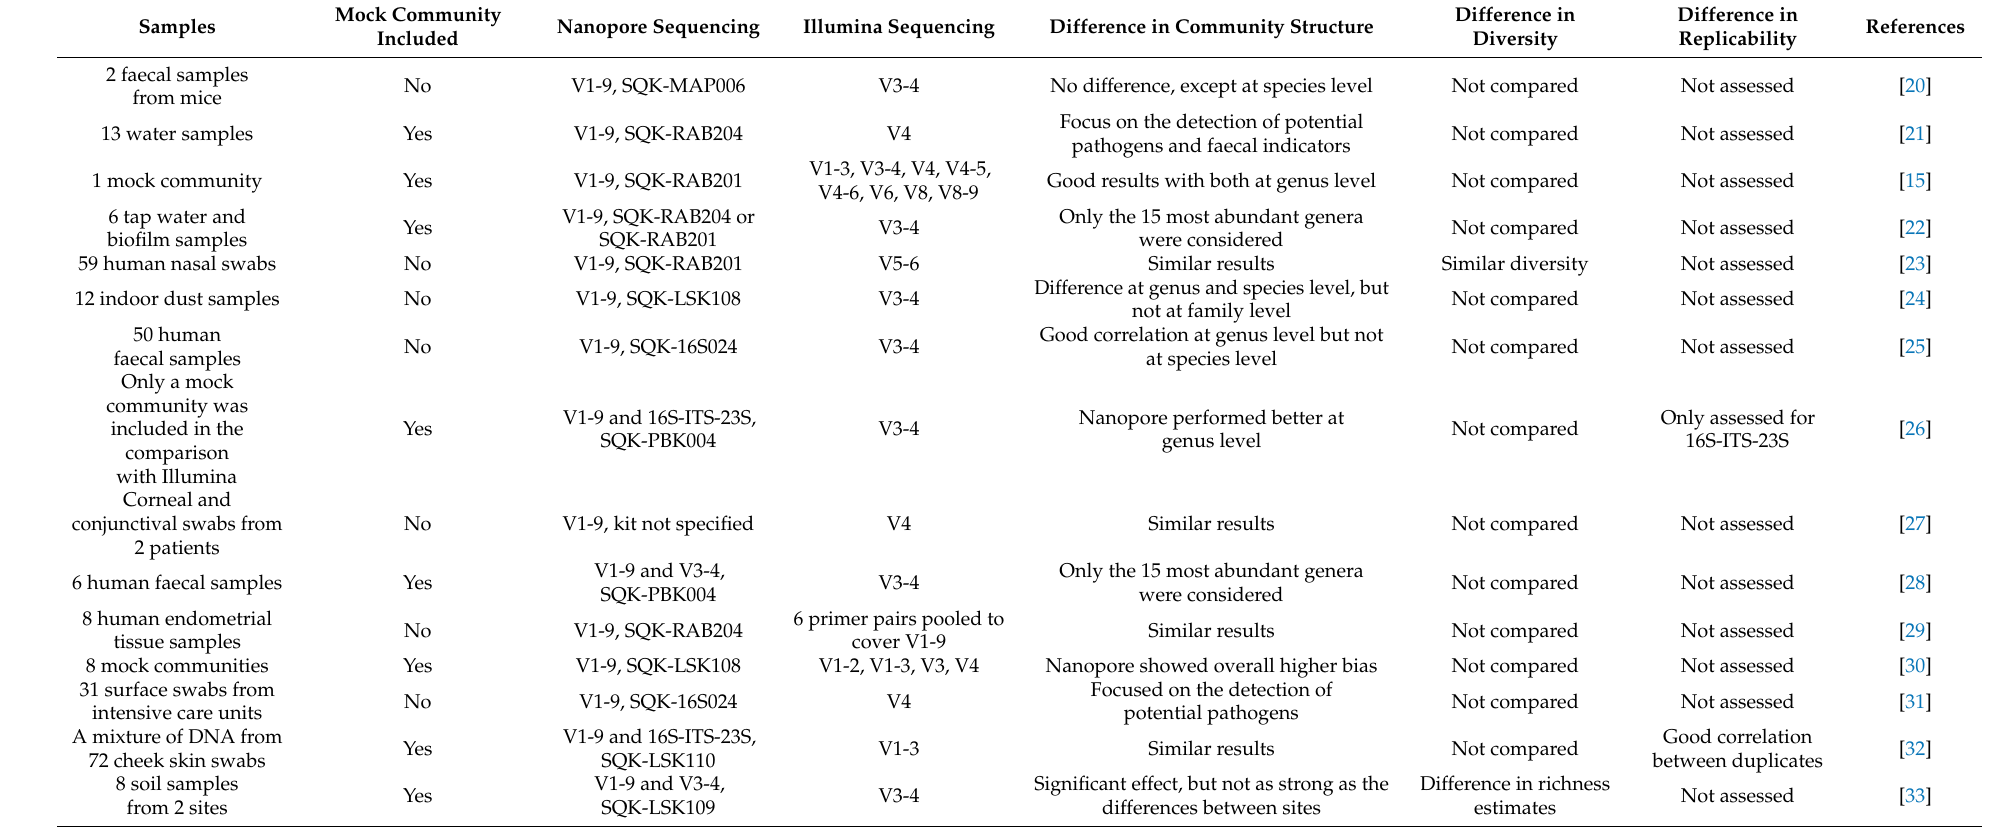
Table 1. Published studies comparing 16S rRNA gene amplicon sequencing with Illumina and